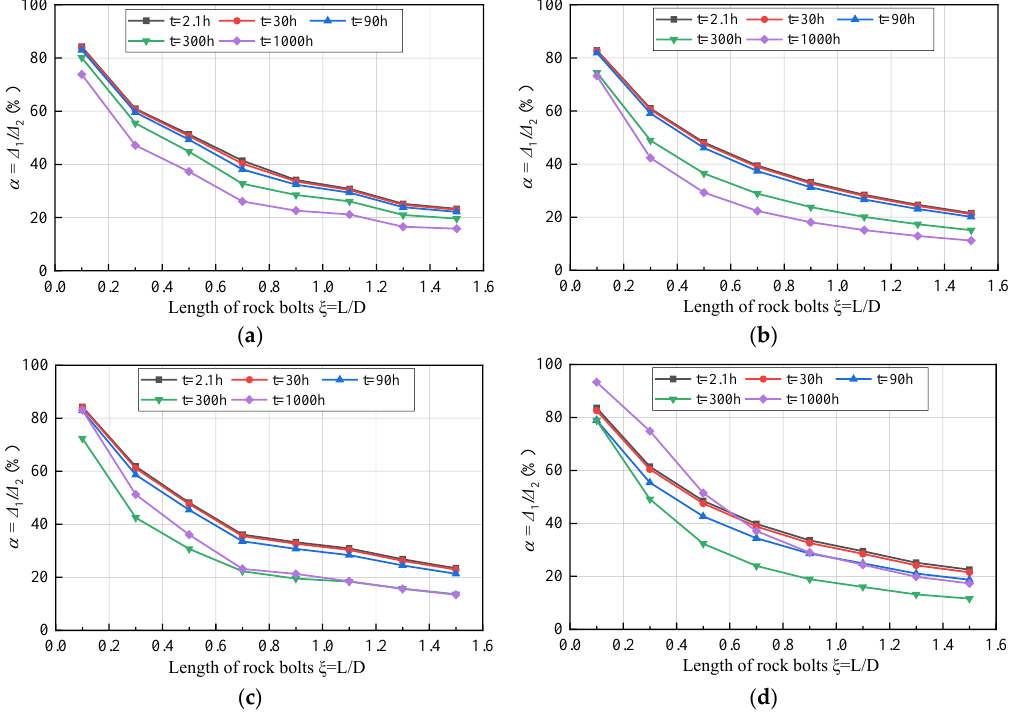
Figure 9. α vs. ξ under different ground stress conditions: ( a ) β = 0.8 (Class A); ( b ) β = 0.4 (Class B); ( c ) β = 0.26 (Class C); ( d ) β = 0.16 (Class